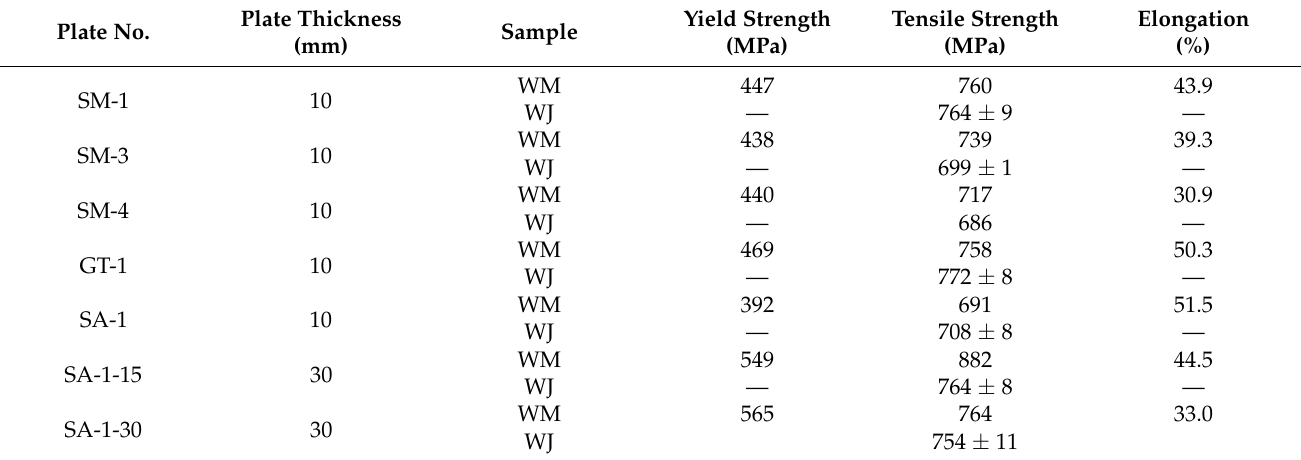
Table 7. Tensile properties of the weld metals and the welded joints at room temperature.